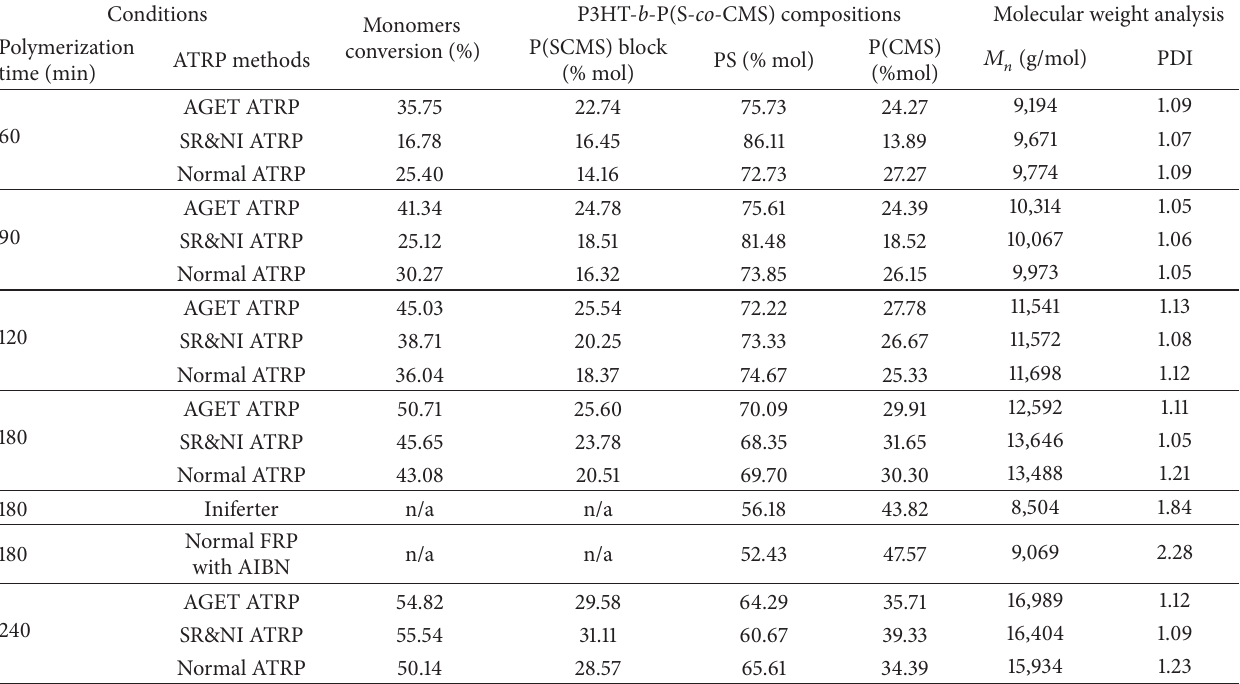
Table3:Monomersconversions,molecularweights,andcompositionsoftheP3HT- b -P(S- co -CMS)copolymersobtainedfromvariousATRP systems.